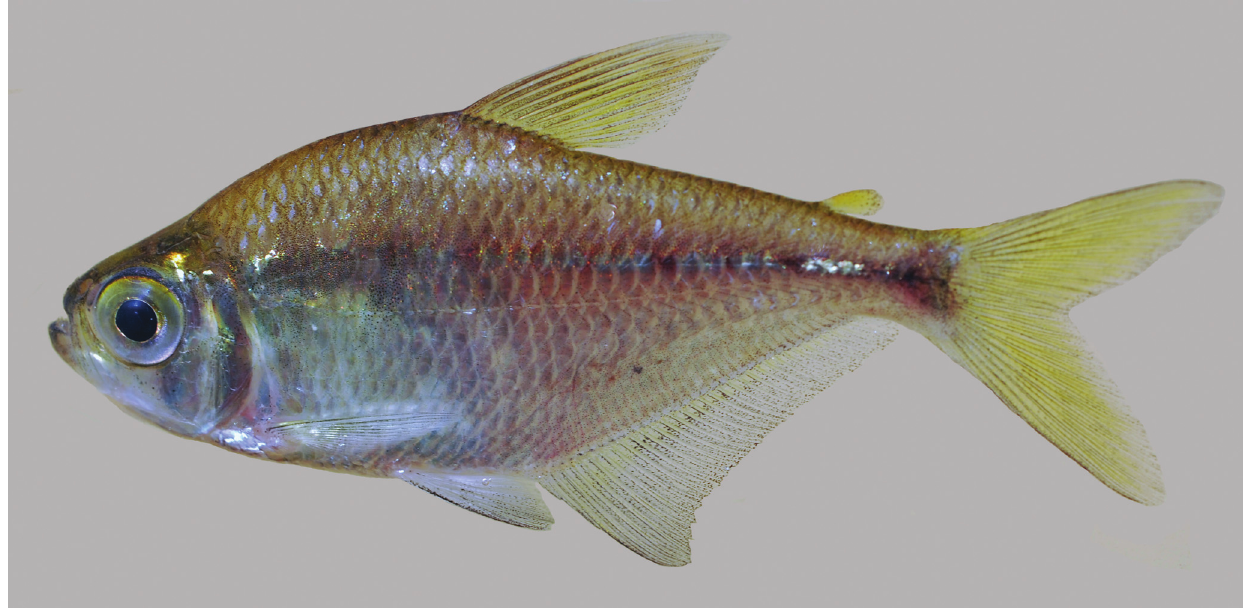
Fig. 3. Moenkhausia doceana , live specimen, not